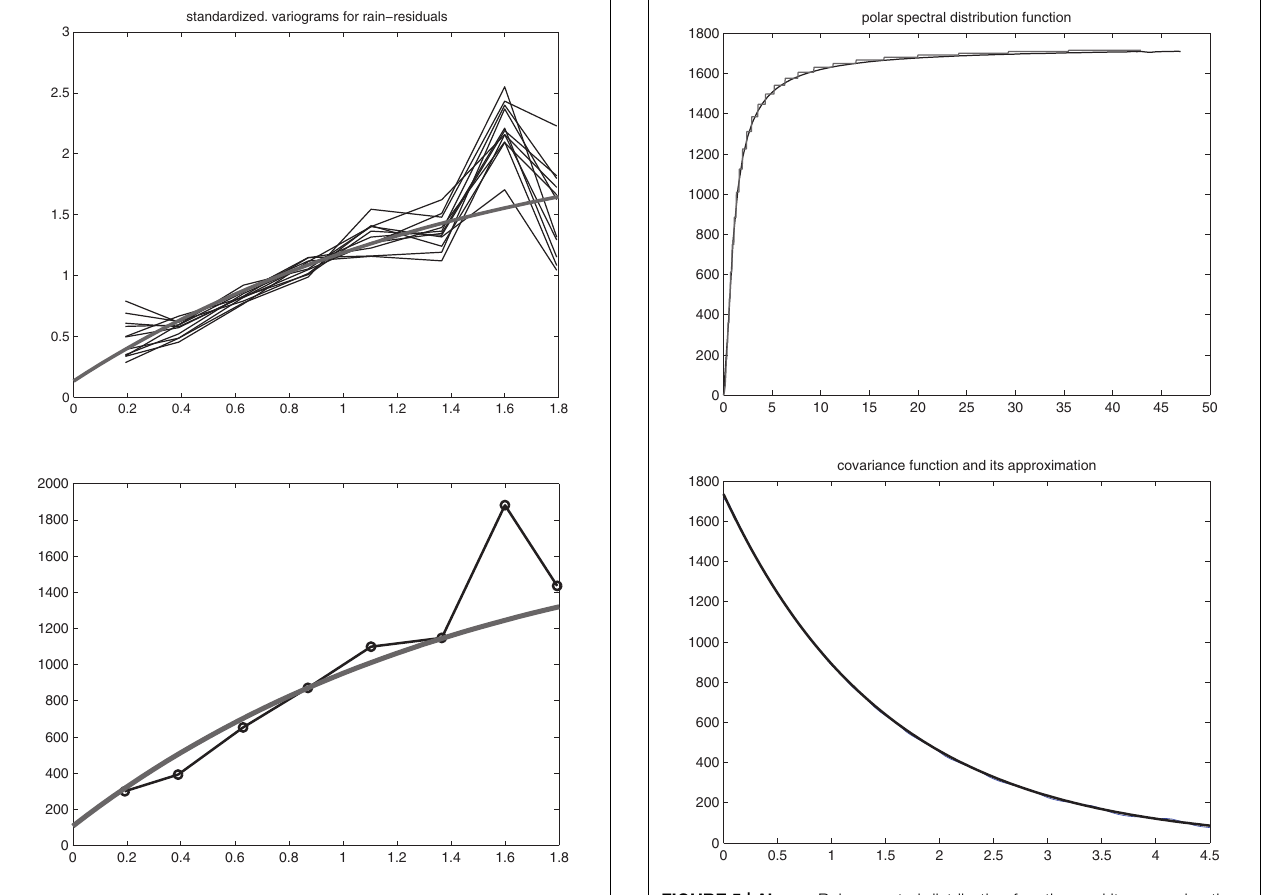
FIGURE 4 | Above: Empirical semivariograms of the standardized rain residuals for all of the 12 months and a fitted exponential semivariogram (gray). Below: Empirical semivariogram for the means of original rain residuals and a fitted exponential semivariogram (gray).